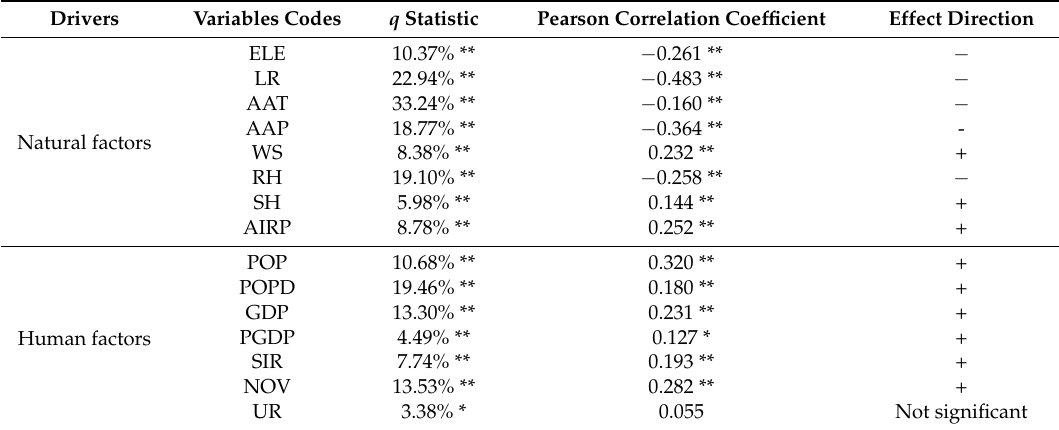
Table 3. Results of the effects of driving factors on air